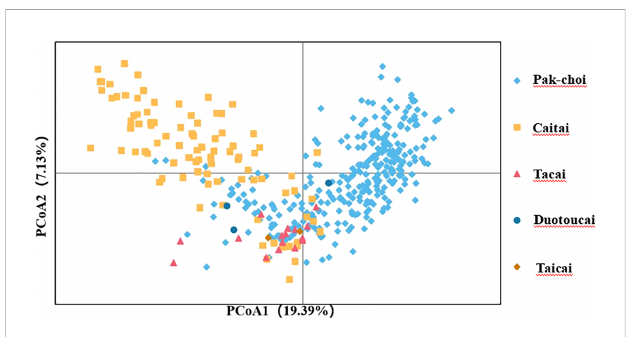
FIGURE 4 Principal component analysis (PCA) of 423 non-heading Chinese cabbage varieties based on 23 simple sequence repeat (SSR) markers. PCA results explained 19.39% and 7.13%, respectively, of the total variance by calculating the fi rst two principal